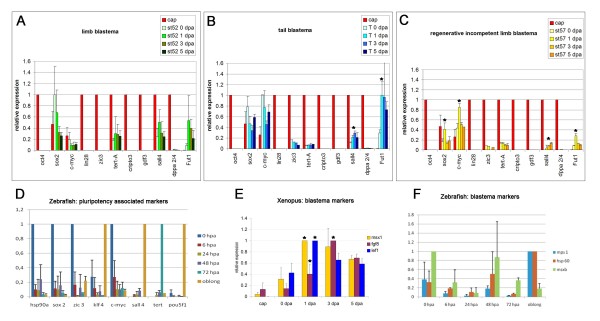
qPCR of a pluripotent cell type compared with cells of the regeneration blastema. A) Relative expression of pluripotency associated genes in Xenopus cap cells compared to limb blastema (st52) at different time points during regeneration. In red is relative expression of animal cap cells, in green the relative expression of st52 limb blastemas at 0 dpa, 1 dpa, 3 dpa and 5 dpa. (note: the results for oct25, oct60 and oct79 expression was combined as oct4 expression). B) Relative expression of pluripotency associated genes in Xenopus cap cells and st52 tail blastema cells. C) Relative expression of pluripotency associated genes in Xenopus cap cells and regenerative incompetent pseudo blastemas of st57 limbs at 0 dpa, 1 dpa, 3 dpa, and 5 dpa. Asterisks indicate significant (P < 0.05) upregulation of expression compared to 0 dpa. D) Relative gene expression for pluripotency associated markers in zebrafish non-regenerating (0 hpa), regenerating (6 hpa to 72 hpa) fin and embryonic cells in oblong stage. E) Relative expression of blastema markers in cap cells and regenerating limbs. Asterisks indicate significant (P < 0.05) upregulation of gene expression compared to the previous time point. F) Relative expression of blastema markers in zebrafish non-regenerating (0 hpa), regenerating (6 hpa to 72 hpa) fin and embryonic cells in oblong stage. For each gene, expression was normalized to highest expressing tissue. Error bars indicate Standard deviation (SD). (For statistical differences see Additional file 1).